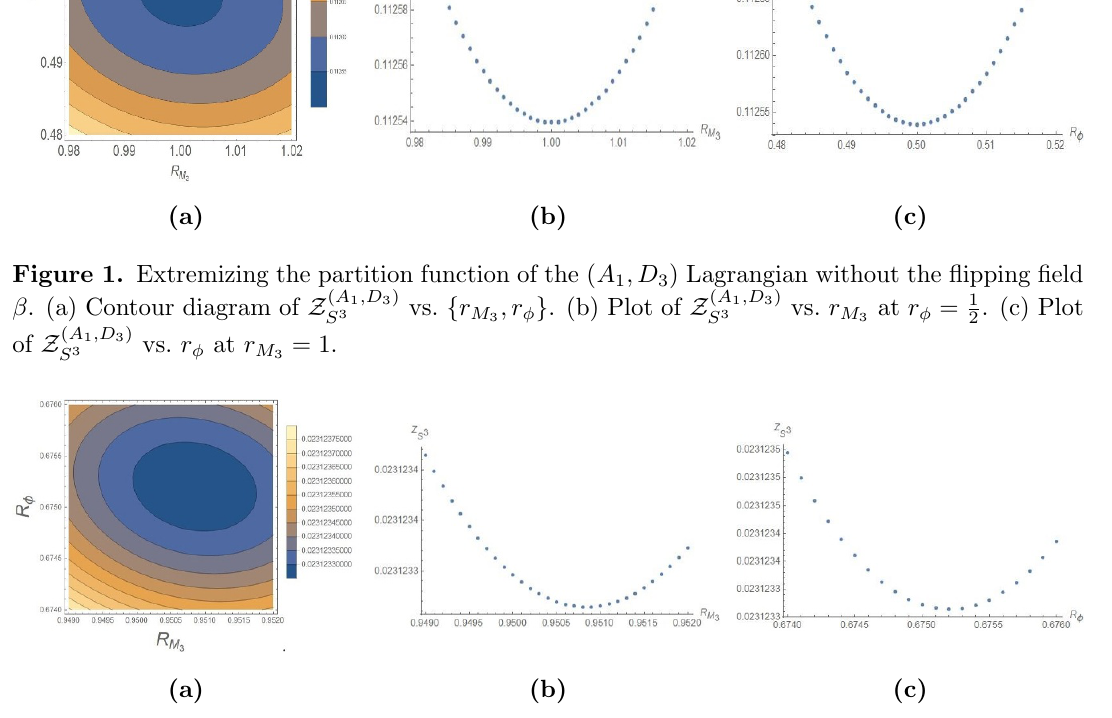
Figure 2. Extremizing the partition function of the ( A 1 ; D 3 ) Lagrangian including the (cid:13)ipping (cid:12)eld (cid:12) . The plots give the values before removing the contribution of the decoupled monopole operator. (a) Contour diagram of Z ( A 1 ;D 3 )+ (cid:12) r (cid:30) = 0 : 6752. (c) Plot of Z ( A 1 ;D 3 )+ (cid:12)